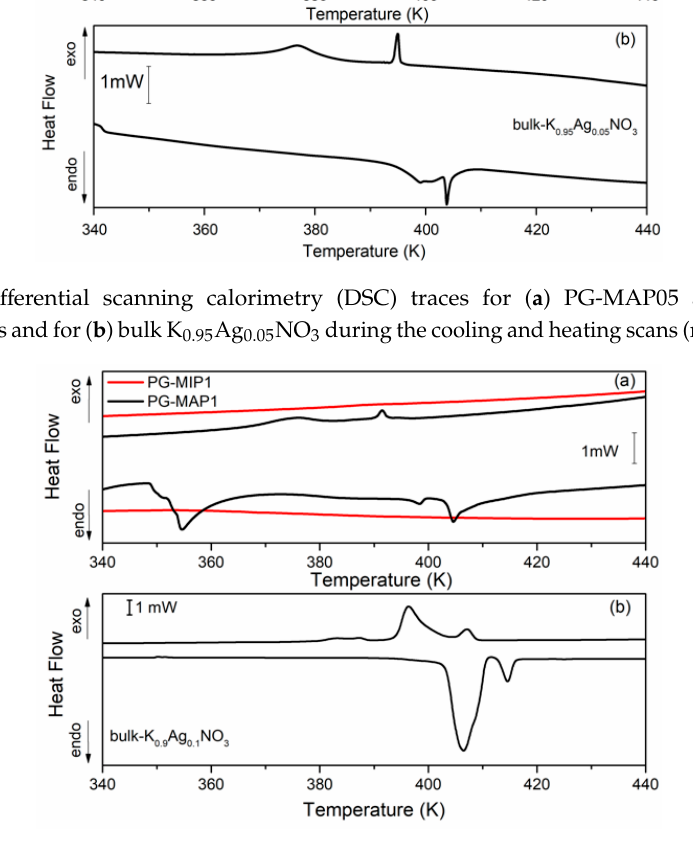
Figure 6. DSC traces for ( a ) PG-MAP1 and PG-MIP1 nanocomposites and for ( b ) bulk K 0.90 Ag 0.10 NO 3 during the cooling and heating scans (rate: 2 K min − 1 ).